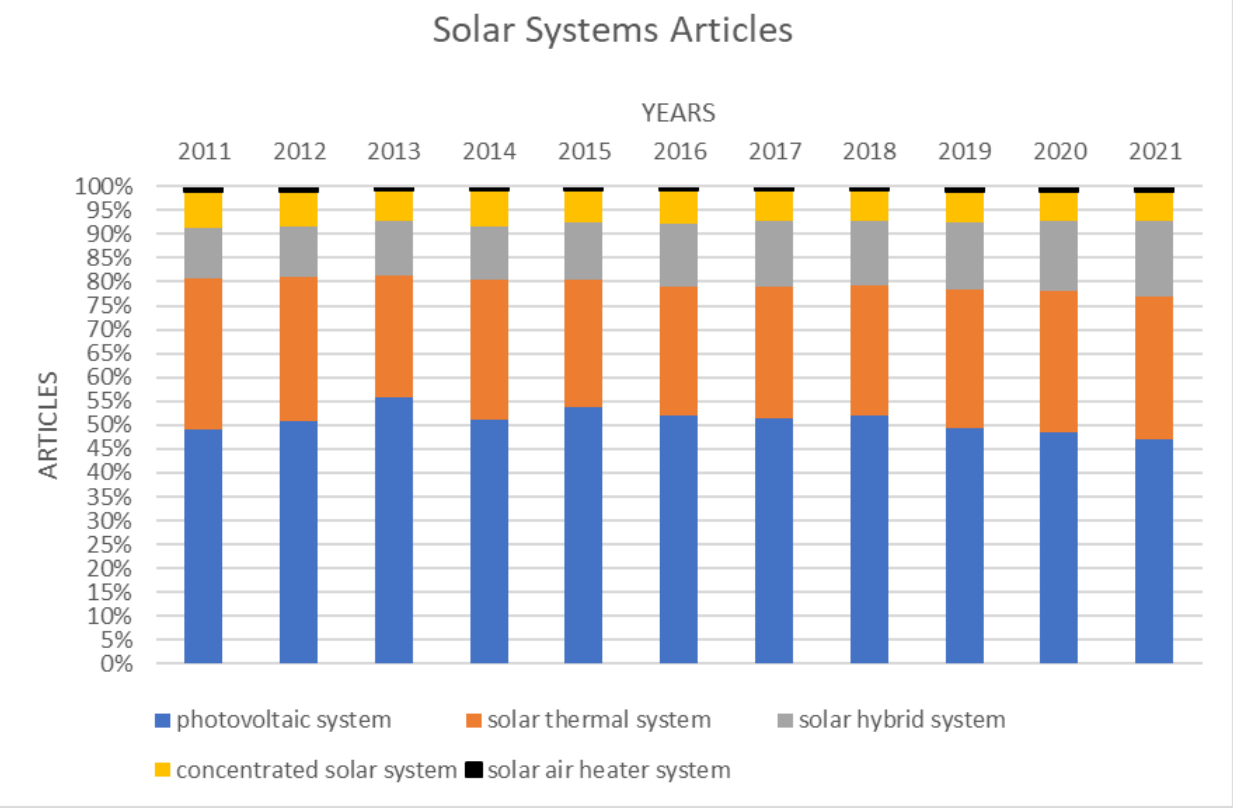
Figure 1. Articles percent for solar systems, period of 2011 – 2021.